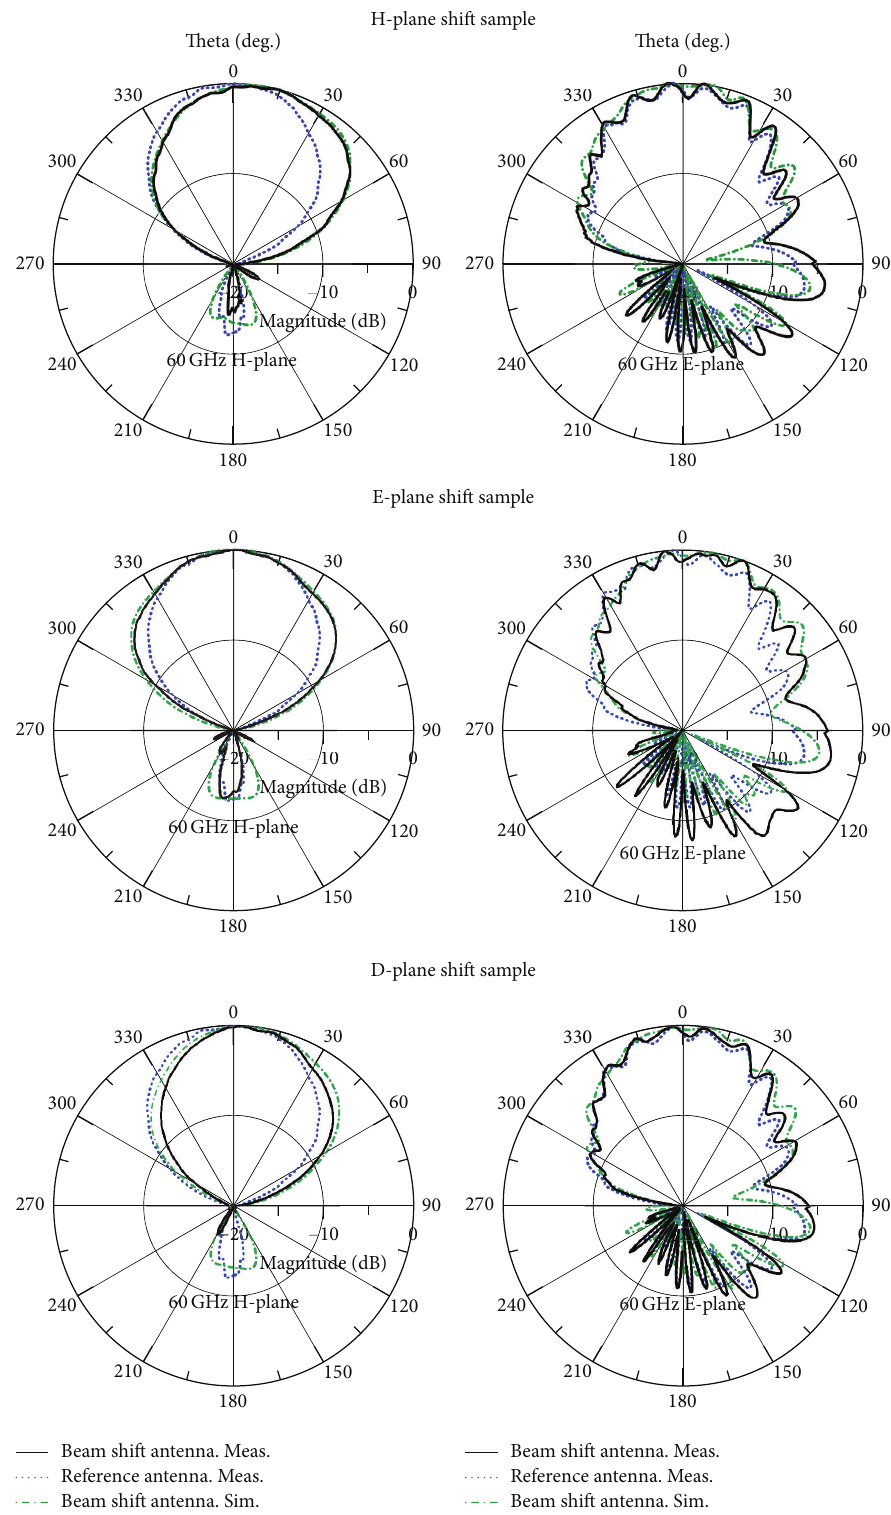
Figure 7: Normalized measured radiation patterns at 60 GHz for the reference antenna compared with measured and simulated radiation patterns for samples with beam shift. Patterns presented in the reference antenna H-plane and